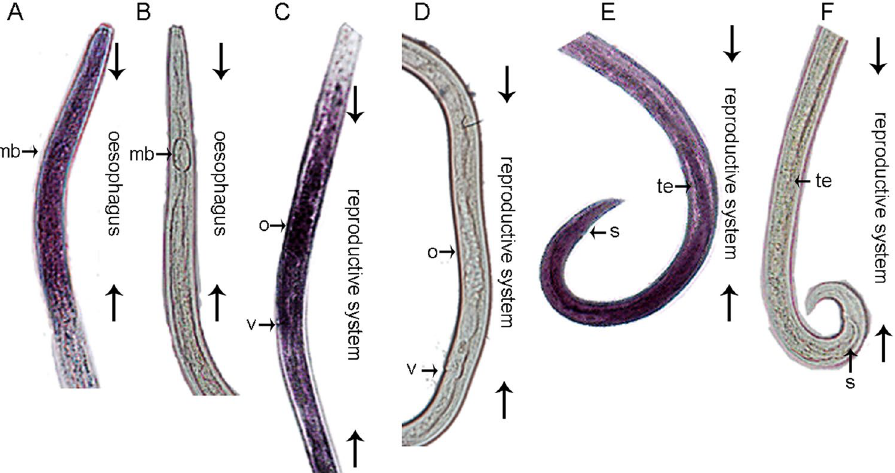
Figure 5. Tissue localization of Aphelenchoides besseyi ATPase mRNA Ab-atps using in situ hybridization. ( A ) Ab-atps mRNA was expressed in the esophagus; ( C , E ) Ab-atps mRNA was expressed in the reproductive system; ( B , D , F ) A hybridization signal was observed in the control nematodes using a DIG-labeled sense Ab-atps RNA probe; mb: medium bulb, o: ovary, s: spicules, te: testis, v: